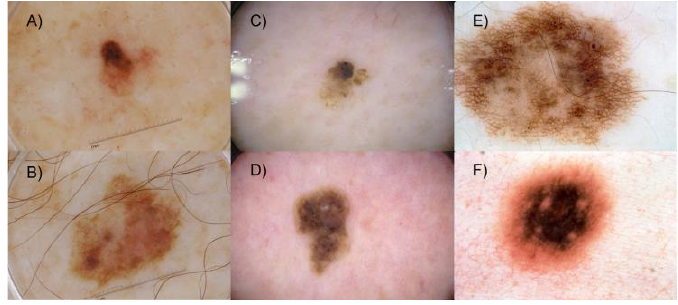
Figure 3. Representative dermatoscopy images of melanoma ( A , B ), seborrheic keratosis ( C , D ), and other lesions ( E,F ) from the ISIC 2017 challenge dataset.